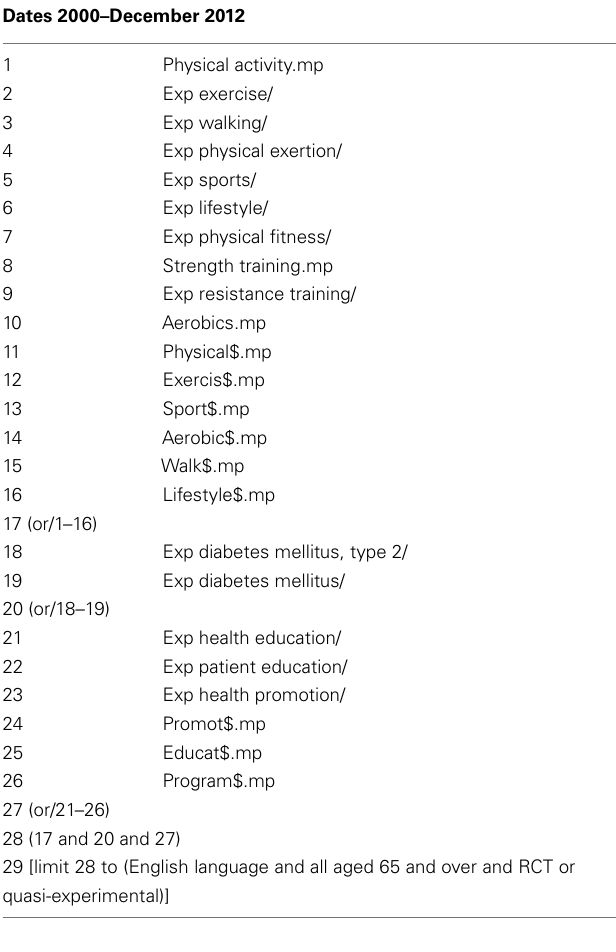
Table 1 | Search strategy used in Ovid MEDLINE